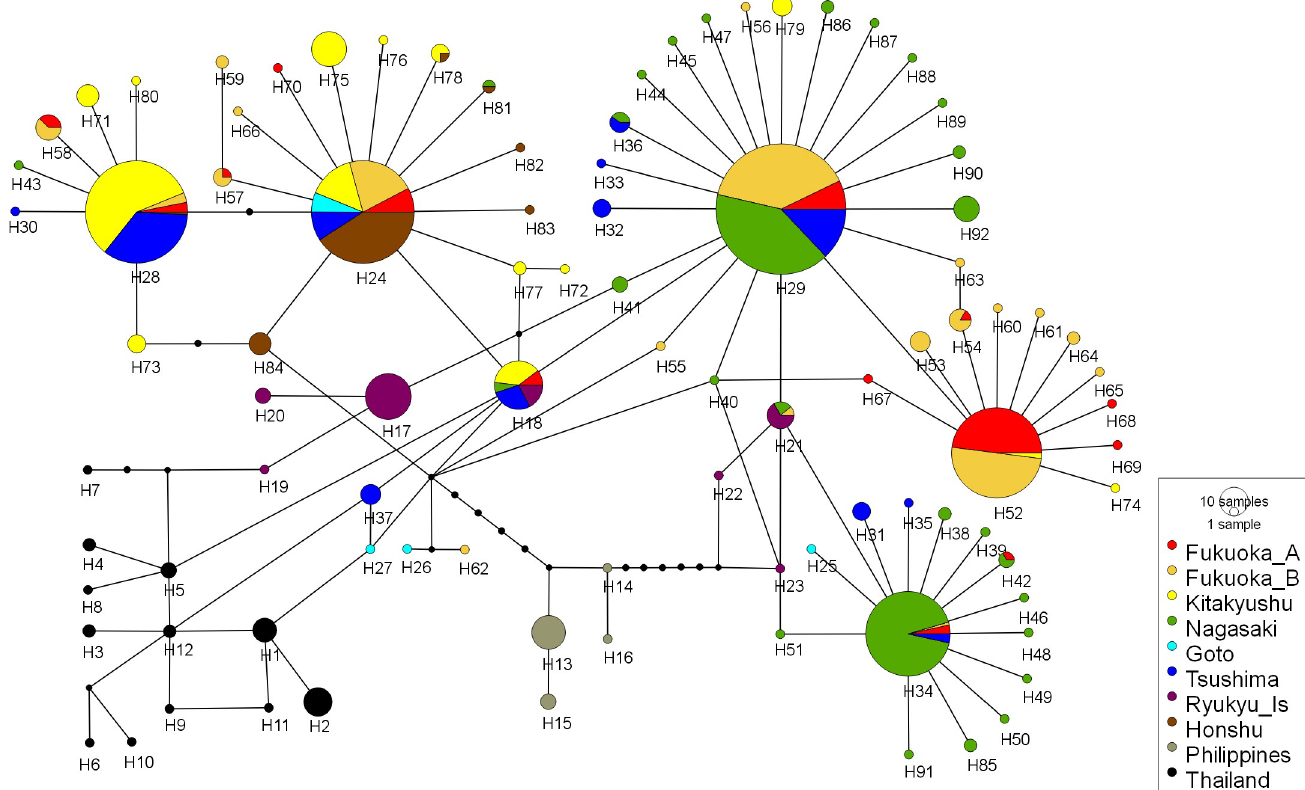
Fig 6. CO1 genetic relationships among ten Aedes albopictus groups.